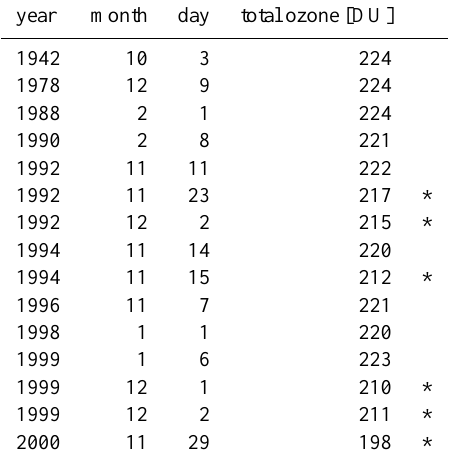
Table 2. Ozone mini-holes (threshold of 225DU applied – follow- ing Br¨onnimann and Hood, 2003) observed over Arosa, Switzer- land, in 1927–2008. Events marked with (*) indicate mini-holes that are found also following the stronger limiting definition of Bo- jkov and Balis (2001) (threshold of